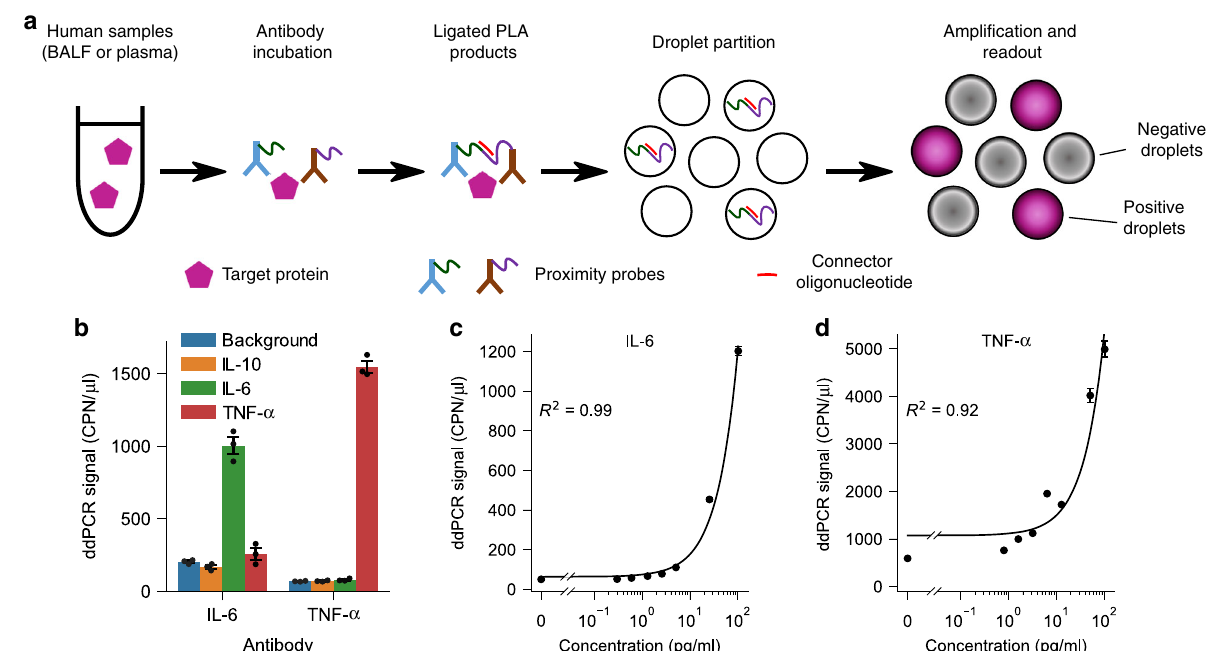
Fig. 1 Ultrasensitive quanti fi cation of human proteins using digital PLA. a In digital PLA, each detected protein molecule is bound by a pair of DNA oligonucleotide-conjugated antibodies (i.e., proximity probes), the oligonucleotides are ligated with the help of a connector, and the ligated products are quanti fi ed by droplet digital-PCR (ddPCR). b The speci fi city of dPLA was tested by using IL-6 and TNF- α antibodies against IL-6, TNF- α and IL-10 spike- in standards. Only IL-6 spike-in produced a high signal with IL-6 antibody, and only TNF- α produced a high signal with TNF- α antibody. c , d Calibration curves for IL-6 ( c ) and TNF- α ( d ) spiked in with healthy human plasma. The solid lines in ( c , d ) are the linear regression of the calibration curves. Data are presented as mean ± s.e.m., and each concentration has three technical